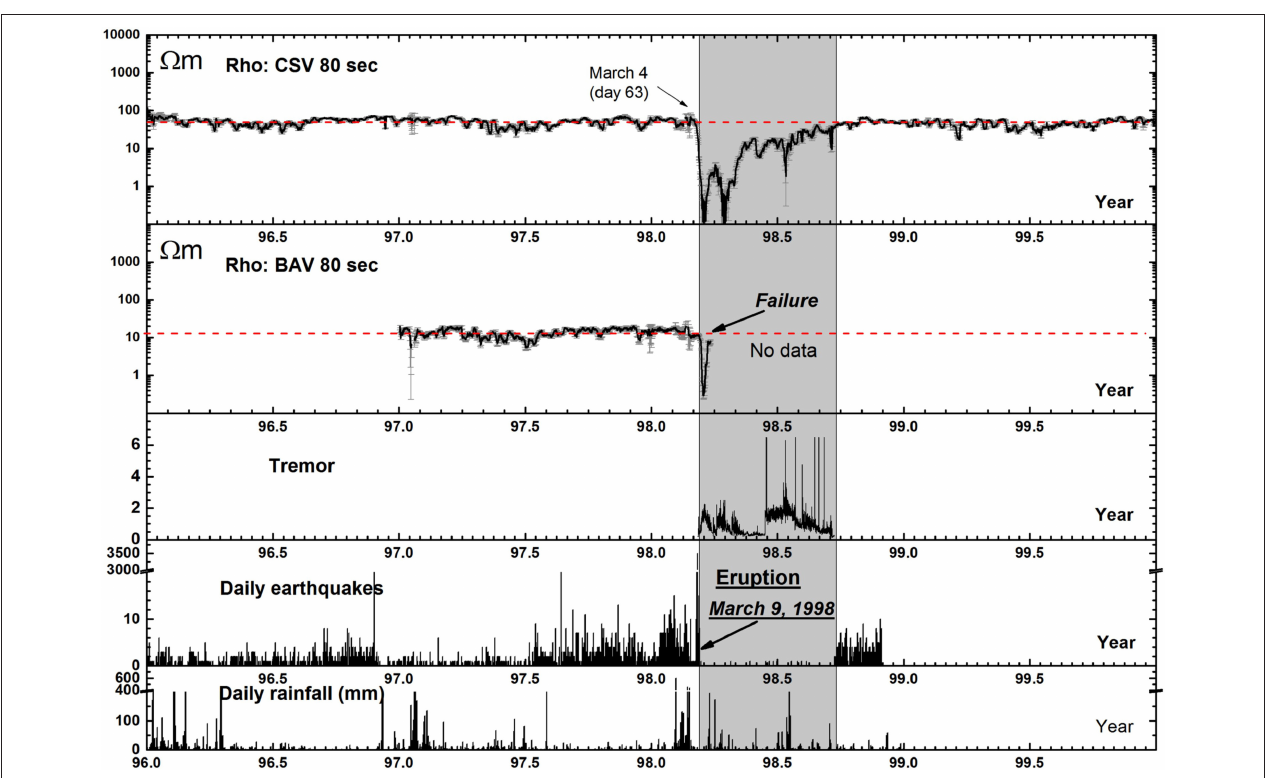
FIGURE 10 | Time-Lapse bounded influence processing, in single site configuration, from Wawrzyniak et al. (2017). From top to bottom: resistivity of the determinant of the impedance tensor values at CSV and BAV for the 80 s period computed by single MT method between 1996 and the end of 1999, tremor activity and daily number of earthquakes, and daily